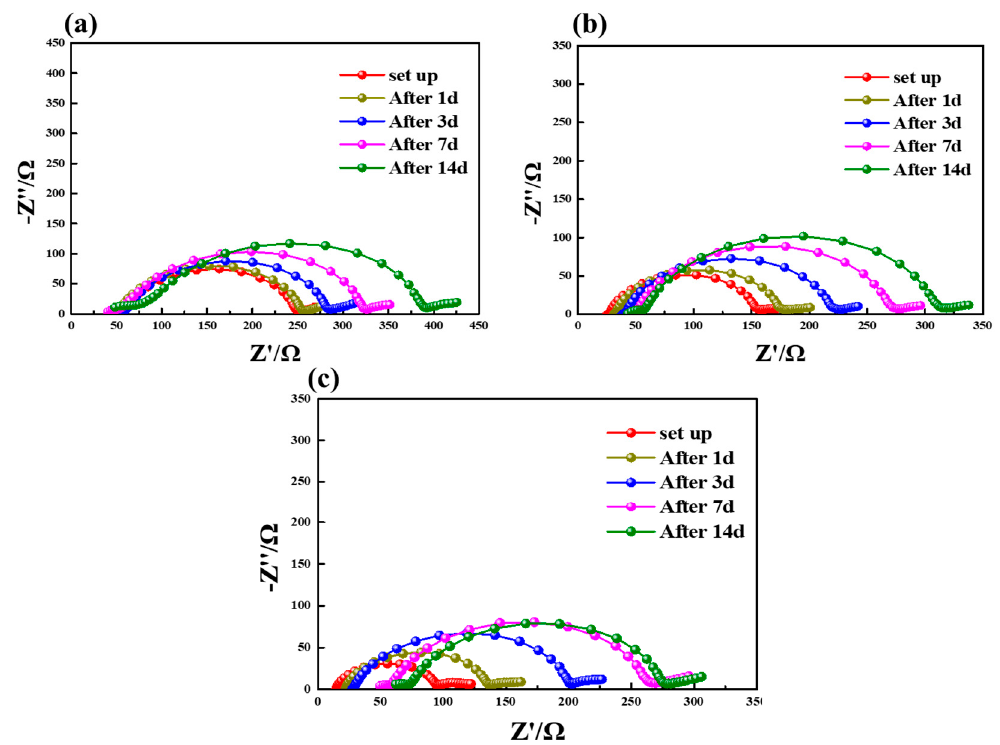
Figure 7. Nyquist plots of Li/GPE/Li cells with GPEs of ( a ) CS-g-PEG-120, ( b ) CS-g-PEG-240, ( c ) CS- g-PEG-480, on days 1, 3, 5, 7 and 14. ( c ) CS-g-PEG-480, on days 1, 3, 5, 7 and